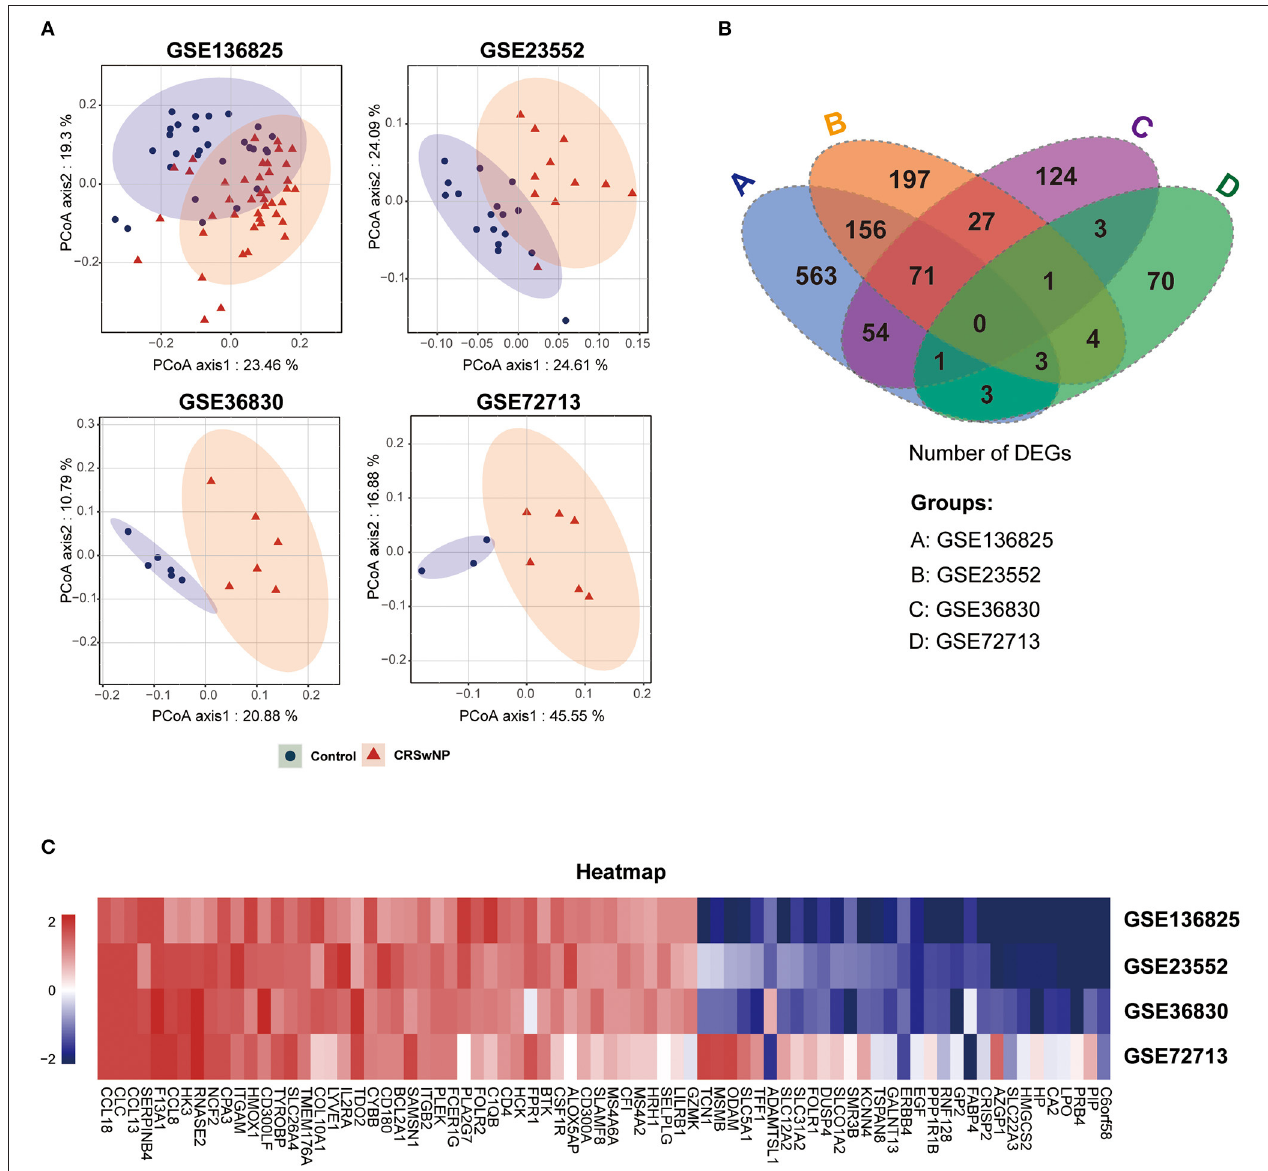
FIGURE 2 | The identification of co-DEGs in four GEO datasets of CRSwNP. (A) Principal coordinate analysis (PCoA) of gene expression in CRSwNP and healthy control subjects in four GEO datasets. (B) Venn diagram showing the number of integrated genes among the four GEO datasets. (C) Gene expression heatmap of the 76 co-DEGs in CRSwNP compared to healthy